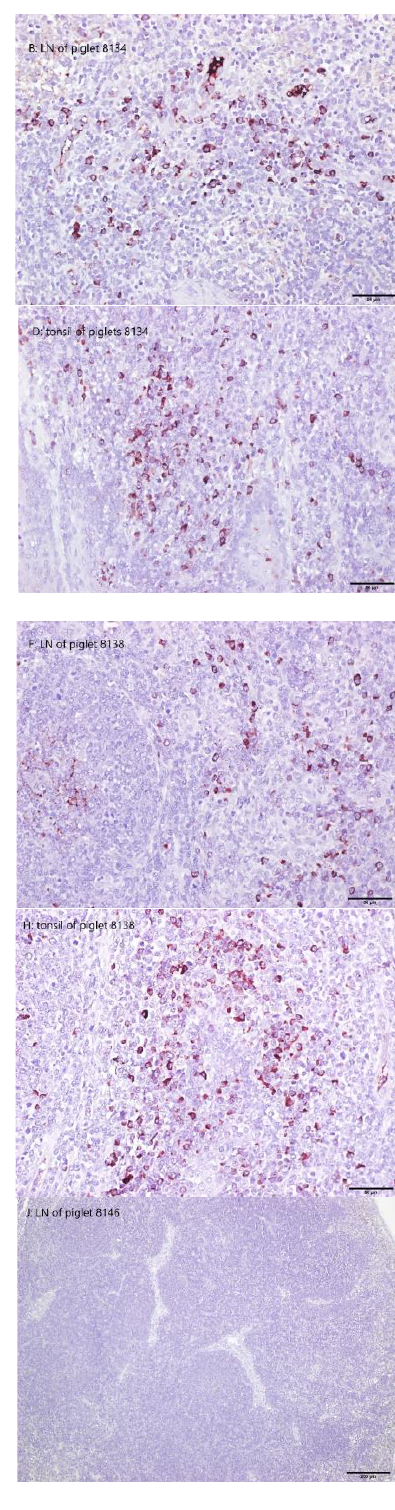
4. Discussion Vaccination is crucial for CSF prevention and control in CSF-endemic areas. A widely applied practice is to provide neonates with MDAs through the colostrum of vaccinated sows and then to administer a single dose of MLV (such as LPC) when the piglets are aged 3 to 6 weeks; this procedure was employed for Group 2 in the present study (Figure 1). Many factors, including vaccine quality, vaccination program procedures (e.g., schedules, types, and routes), and pigs’ MDA levels and health statuses (including individual varia- tion), can influence the efficacy of CSFV vaccination, reducing protection against infection [14 – 16]. In the present study, although the piglets in Groups 2 and 3 had high MDA levels at 1:32 – 128-fold at 7 DPE (Figure 5A; i.e., 0 DP1C with the Group 1 CSFV donor; Figure 1), the MDAs delayed the progress of the infection, as indicated by the late appearance of the viremia at 10 DP1C (Groups 2 and 3; Figure 2A). This caused the piglets to be asymp- tomatic (Table 1), although some of the piglets still shed the virus in their saliva and feces